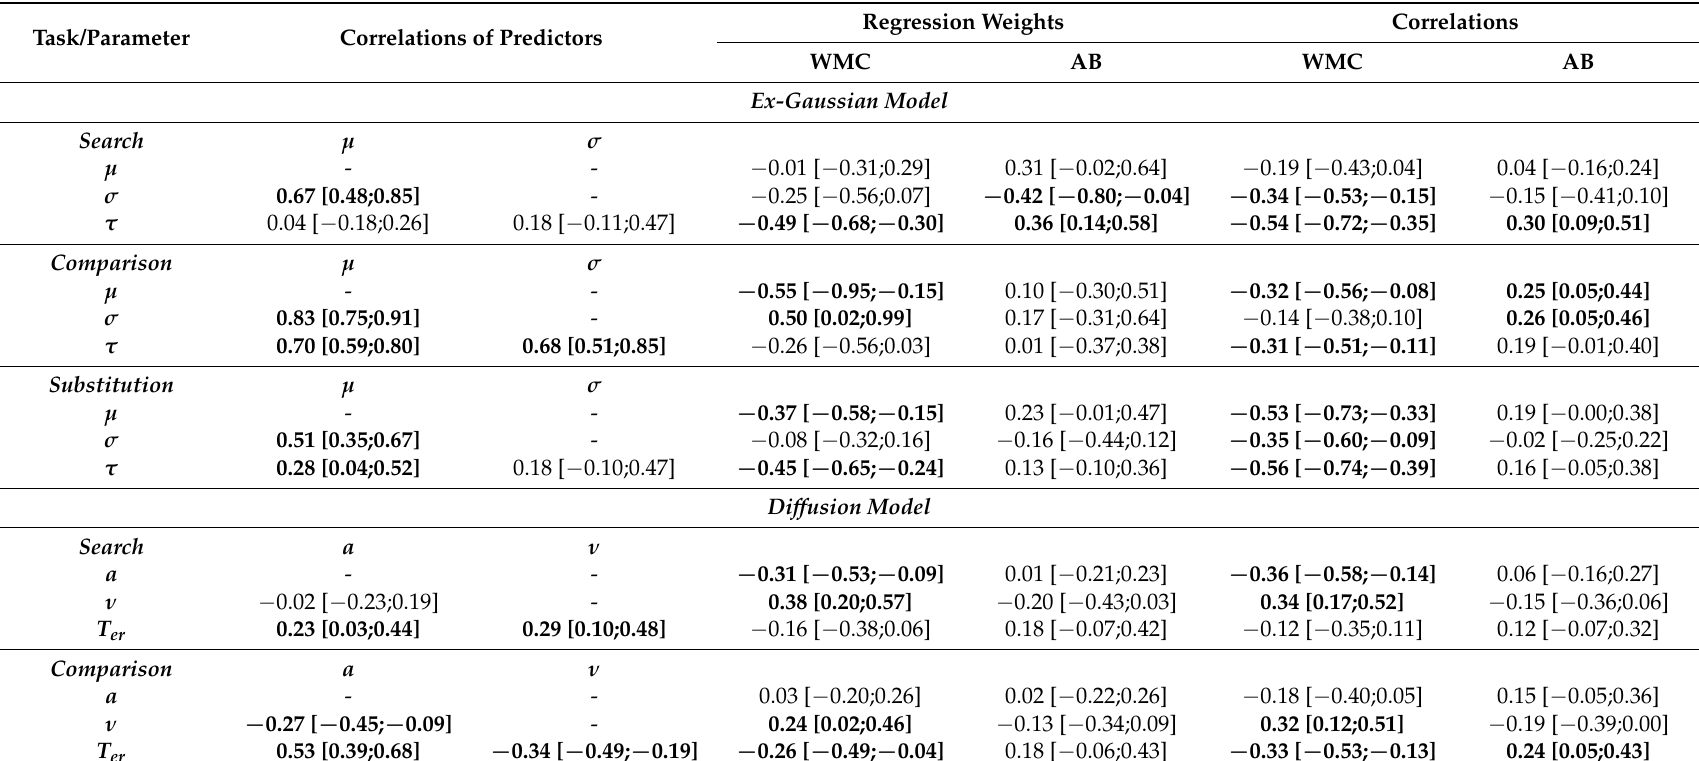
Table 4. Latent variables regression and correlation models with WMC and